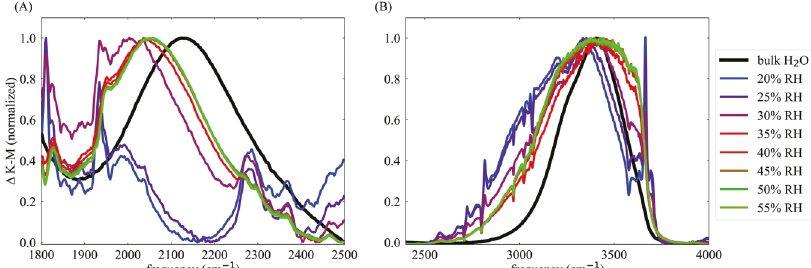
Fig. 5 Infrared spectra of water con fi ned in NU-1500-Cr as a function of RH compared to bulk water. Spectra were normalized to the maximum IR signal after subtracting a spectrum of activated NU-1500-Cr to reduce the in fl uence of framework peaks in ( A ) the bend + libration combination band, and ( B ) the OH-stretch region region of the